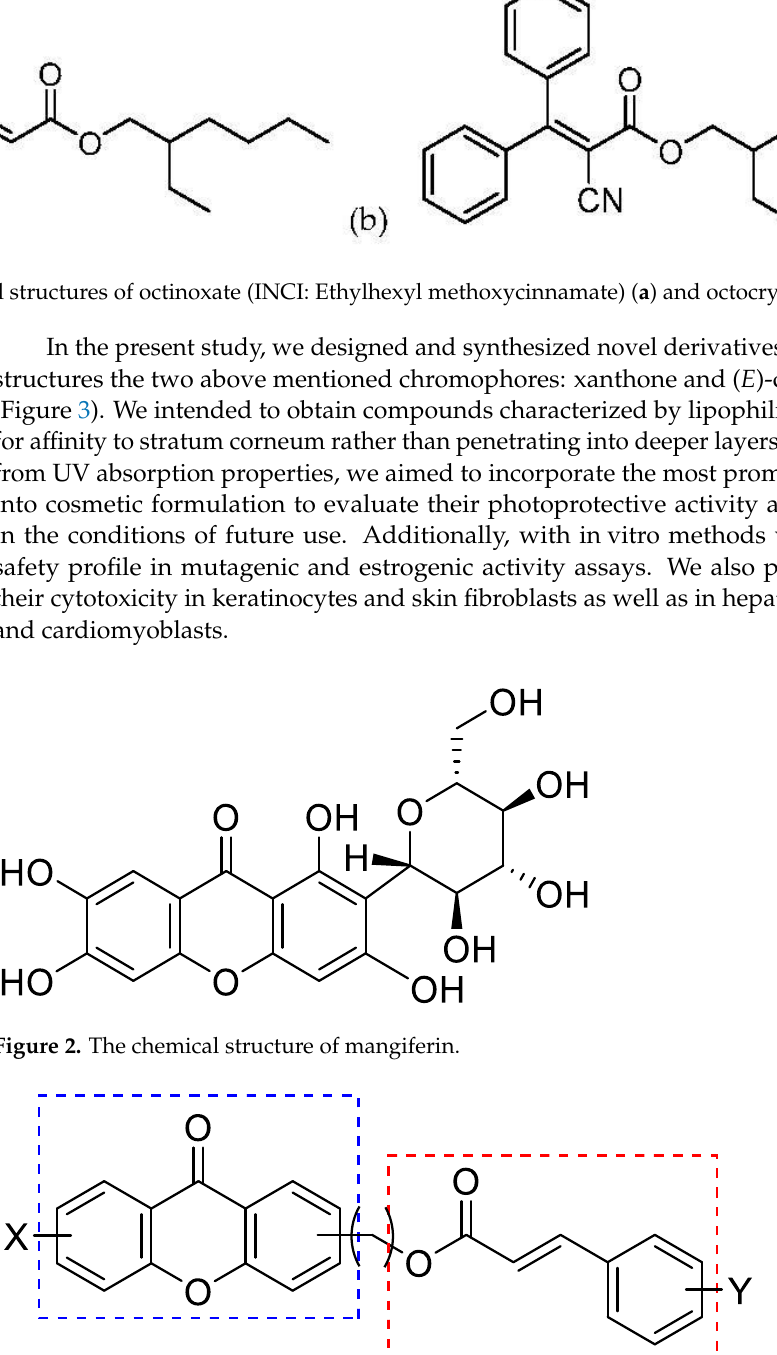
Figure 2. The chemical structure of mangiferin.